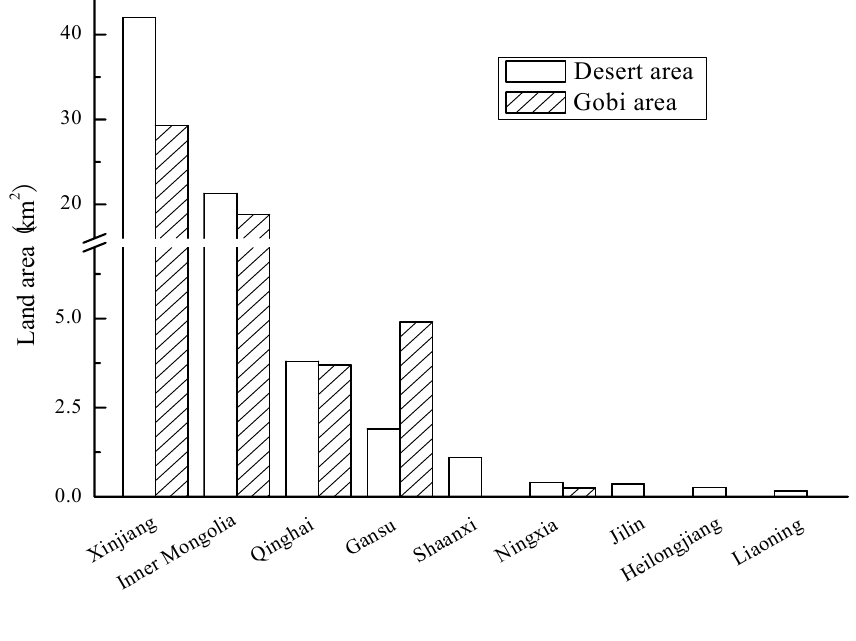
Figure 5. The desert and Gobi areas of China